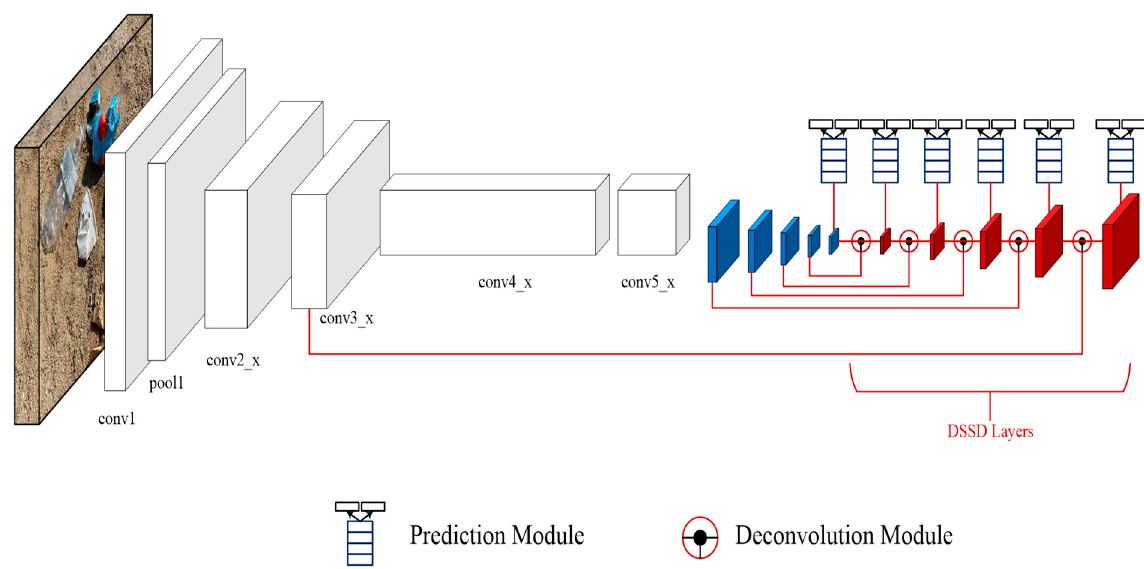
Figure 3. The basic structure of DSSD .